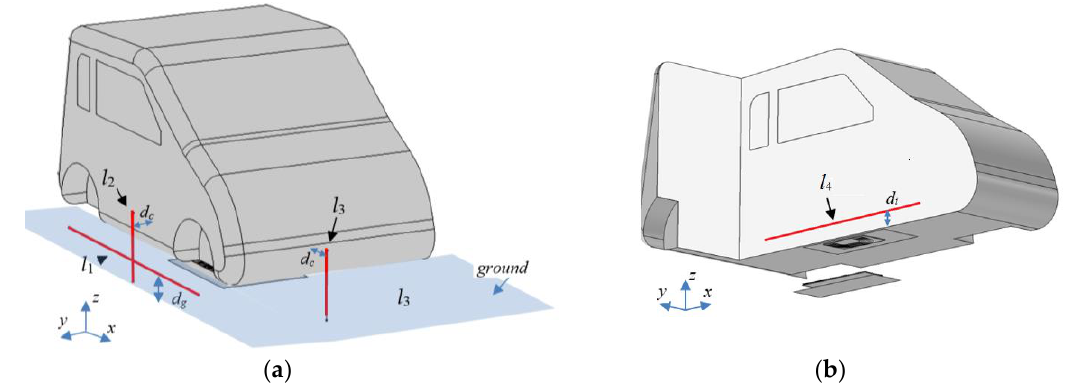
Figure 18. Measurement lines of the magnetic field outside ( a ) and inside ( b ) the vehicle .